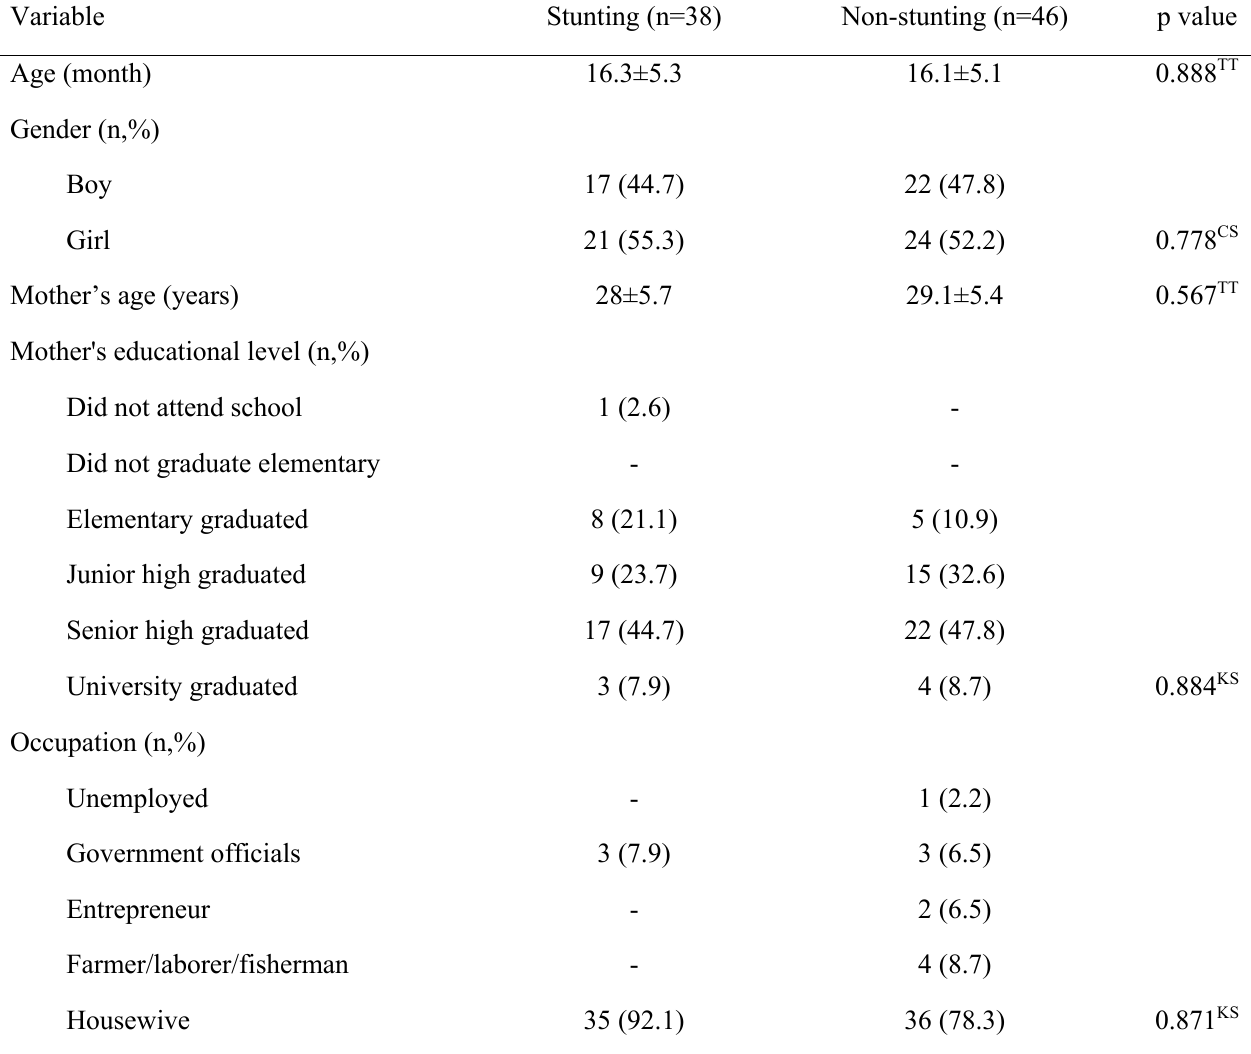
Table 1. Subject baseline